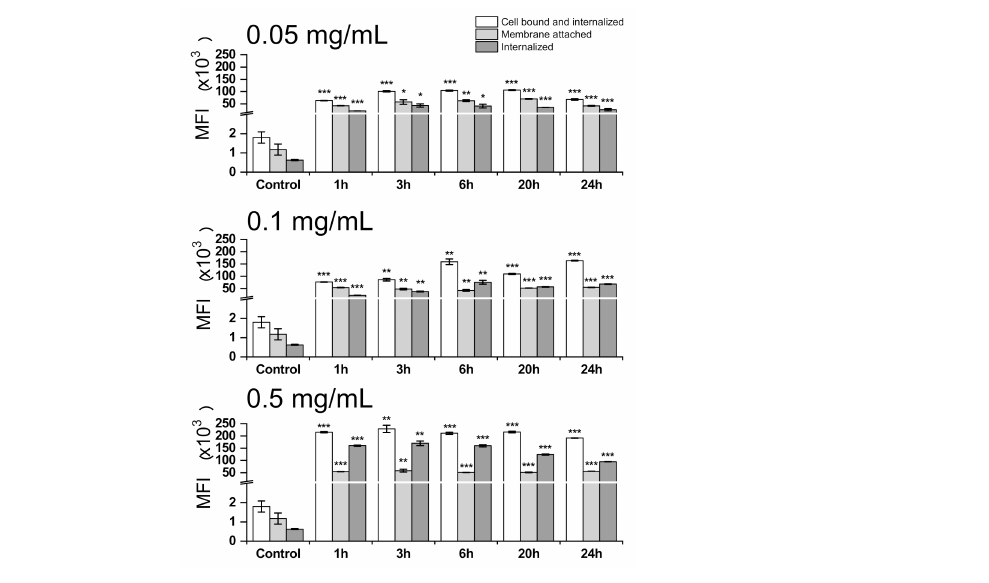
Figure 7. Flow-cytometric analysis of time kinetics and concentration-dependent PIPOx-FITC pro- cessing by RAW 264.7 macrophages. The PIPOx-FITC cell bound and internalized by RAW 264.7 macrophages was analyzed by exposition of cells for 1, 3, 6, 20, and 24 h with 0.05 mg/mL, 0.1 mg/mL and 0.5 mg/mL or FITC-labeled PIPOx using flow cytometry. The internalized PIPOx-FITC was ana- lyzed after Trypan blue quenching. The amount of membrane attached PIPOx-FITC is expressed as a difference between the cells with cell bound and internalized PIPOx-FITC and Trypan blue quenched cell population (internalized PIPOx-FITC). Cell bound and internalized, membrane attached and internalized PIPOx-FITC were expressed as mean fluorescence intensities (MFI) of 10,000 analyzed cells. All data are shown as Mean ± SD. Tests were done in triplicate. The statistical significance of differences between control cells and stimulated cells by means of one-way ANOVA and post hoc Bonferroni’s test is presented as: ***— p < 0.001, **—0.001 < p < 0.01, *—0.01 < p < 0.05.